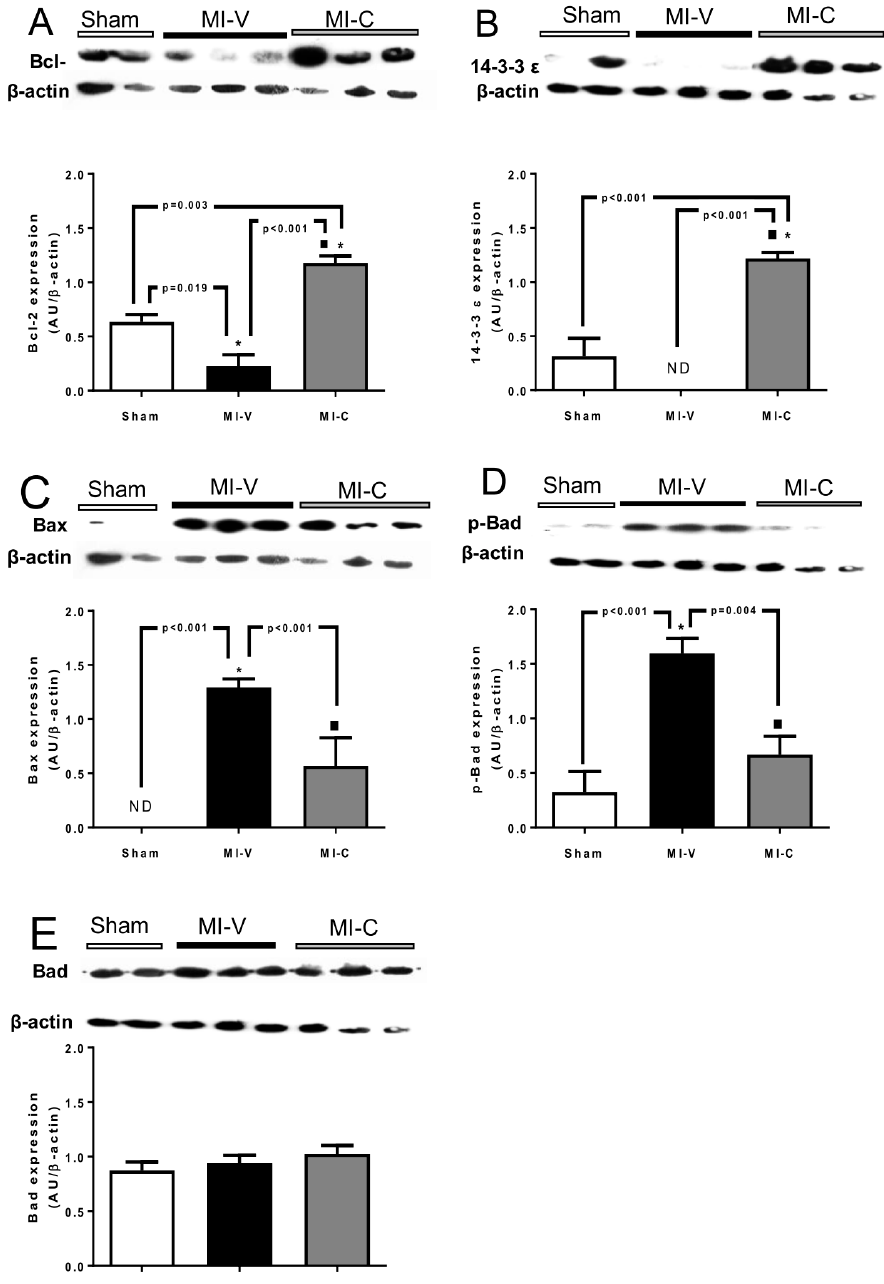
Figure 4. Changes of protein expression on pro- and anti-apoptotic proteins in Sham, myocardial infarction-vehicle treated (MI-V), and MI-clofibrate (MI-C) treated rats. Representative Western blot and densitometric analysis of ( A ) Bcl-2 protein, ( B ) 14-3-3 ε protein, ( C ) Bax protein, ( D ) p-Bad protein, and ( E ) Bad protein. β -actin was used as load control and for densitometric normalizing. Images corresponding to β -actin were re-used for illustrative purposes. Bars represent the mean ± standard error; n = 6 rats per group, ANOVA-Tukey * p < 0.05 vs. Sham and ■ p < 0.05 vs. MI-V.